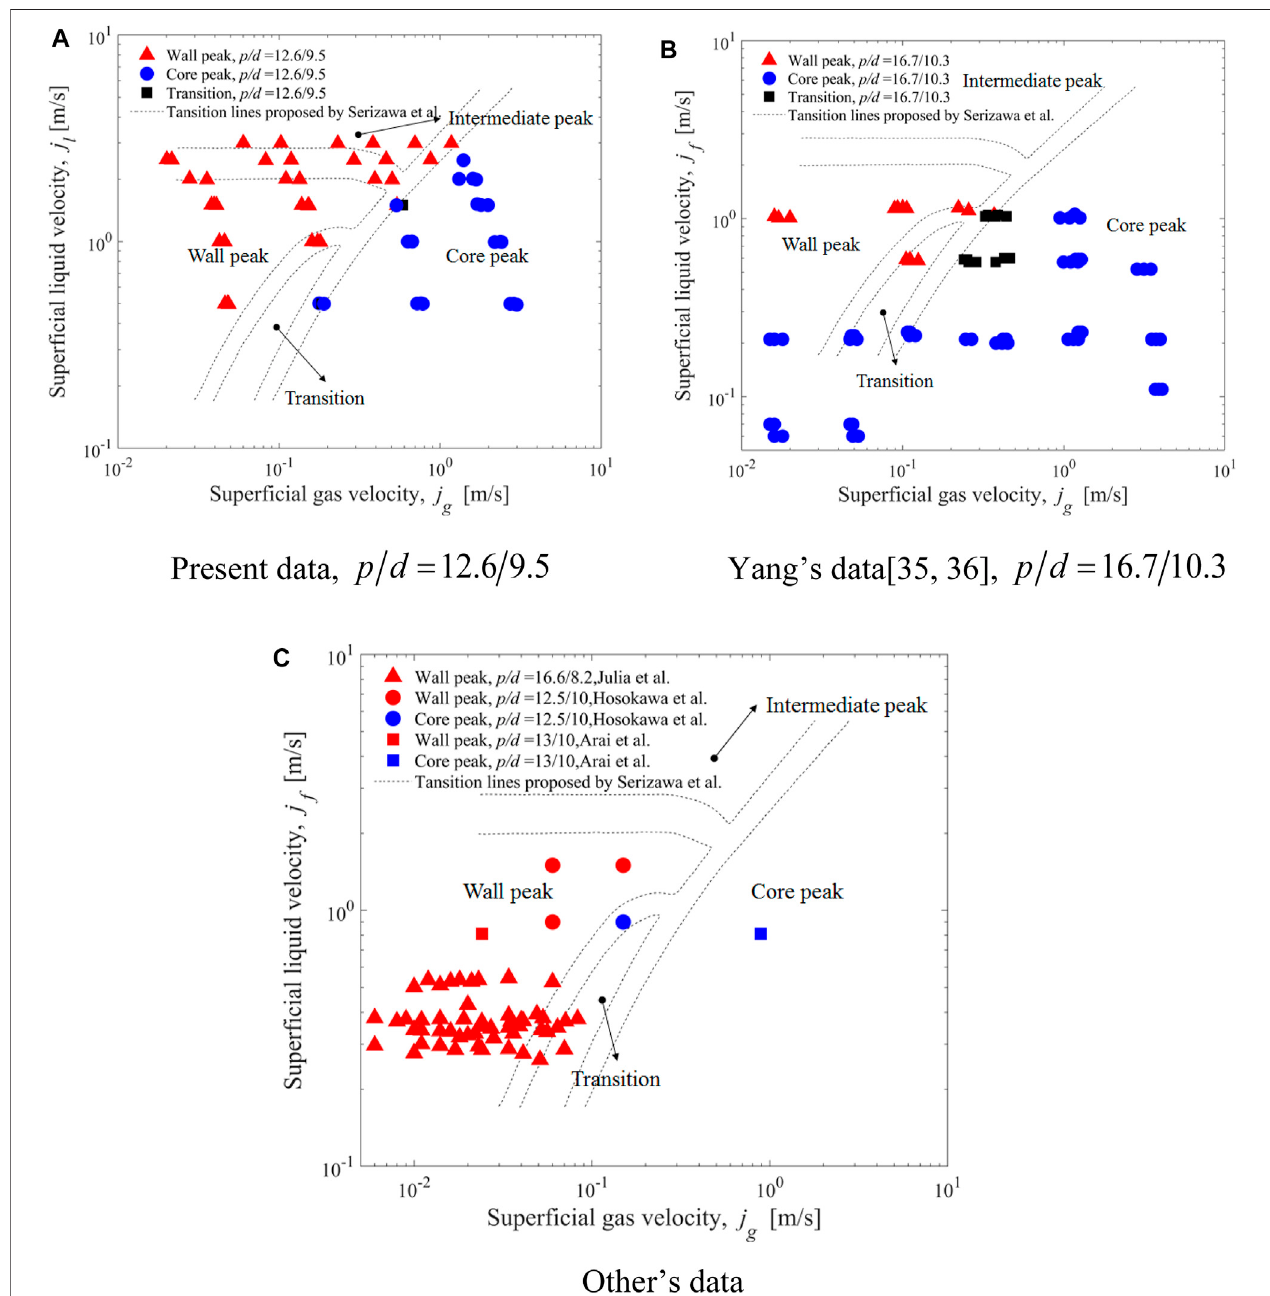
FIGURE 13 | In fl uence of geometrical size on phase distribution. (A) Present data, p / d (cid:2) 12 . 6 / 9 . 5. (B) Yang ’ s data (Yang, 2011; Yang, 2015). (C) Others ’ data.